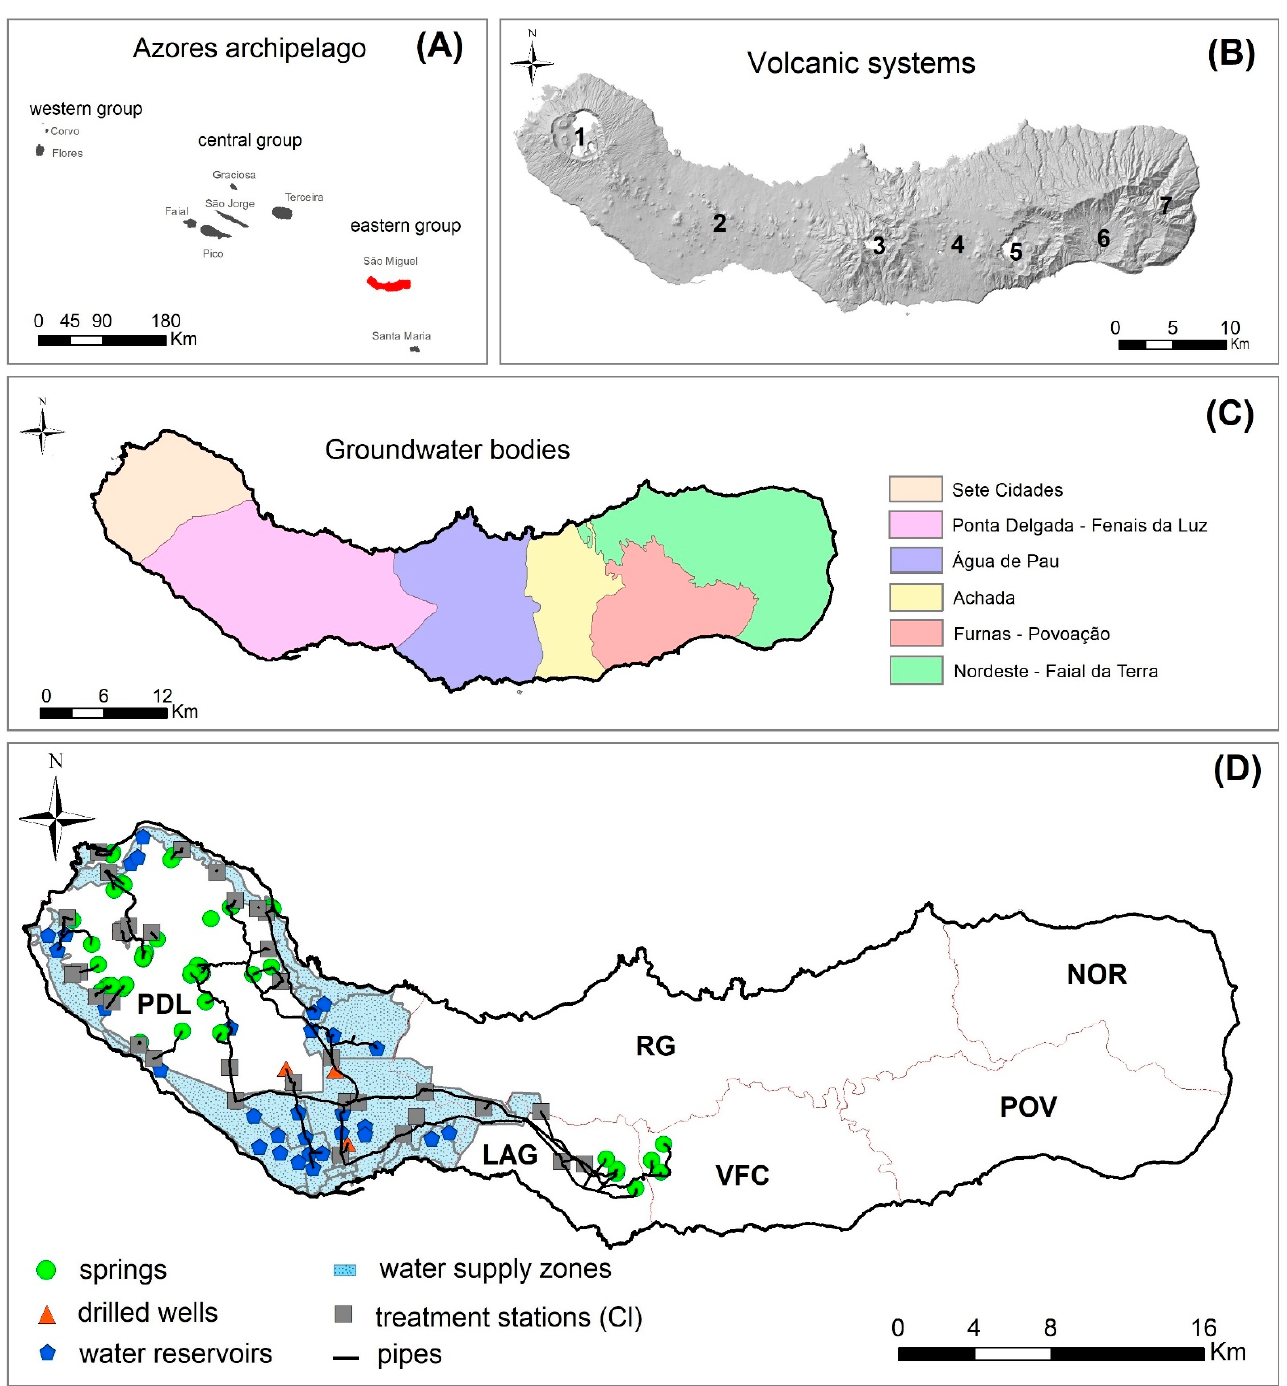
Figure 1. Study area setting: ( A ) Location of São Miguel Island in the Azores archipelago; ( B ) volcanic systems of São Miguel from west to east (1—Sete Cidades Volcano; 2—Picos Fissural Volcanic System; 3—Fogo Volcano, also known as Água de Pau Volcano; 4—Congro Fissural Volcanic System; 5—Furnas Volcano; 6—Povoação Volcano; 7—Nordeste Volcanic System; according to [38]); ( C ) groundwater bodies delimitation from [39]; ( D ) layout of the water supply system from Ponta Delgada (data from SMAS) and Municipalities (PDL—Ponta Delgada; LAG—Lagoa; RG—Ribeira Grande; VFC—Vila Franca do Campo; POV–Povoação; NOR—Nordeste).